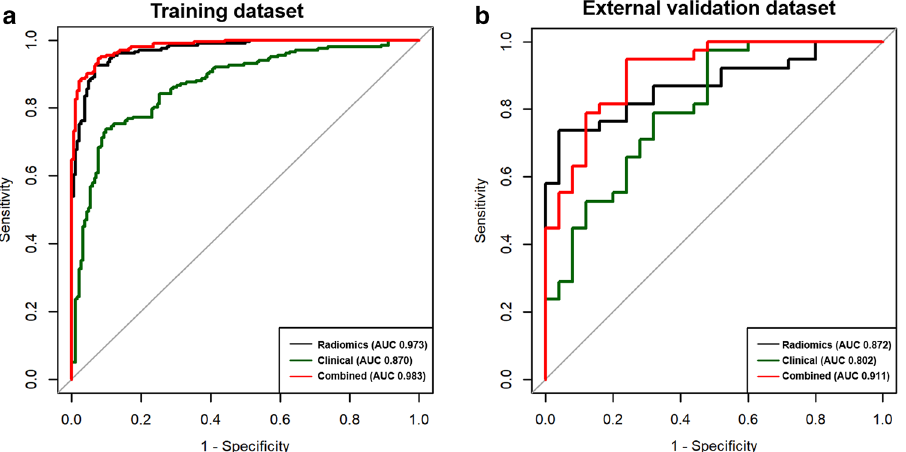
Figure 3. ROC curve of the radiomics model, clinical model, and combined model with radiomics and clinical model to predict cardiac tumor in different datasets. ( a ) The training dataset. ( b ) The external validation